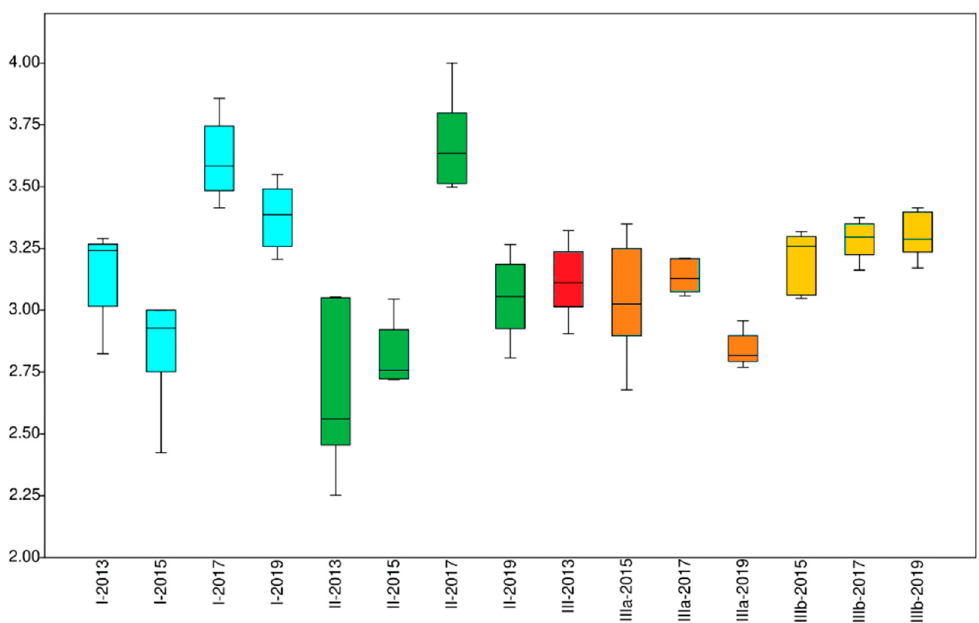
Figure 3. Shannon diversity of the sample areas I–III. ( p < 0.05).